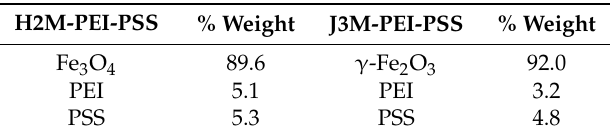
Figure 3. Thermograms of uncoated ( a ) and coated ( b ) magnetic MNRs. Table 2. Mass percentage of the components (inorganic and polymeric) of bare and coated magnetic NRs calculated from TGA